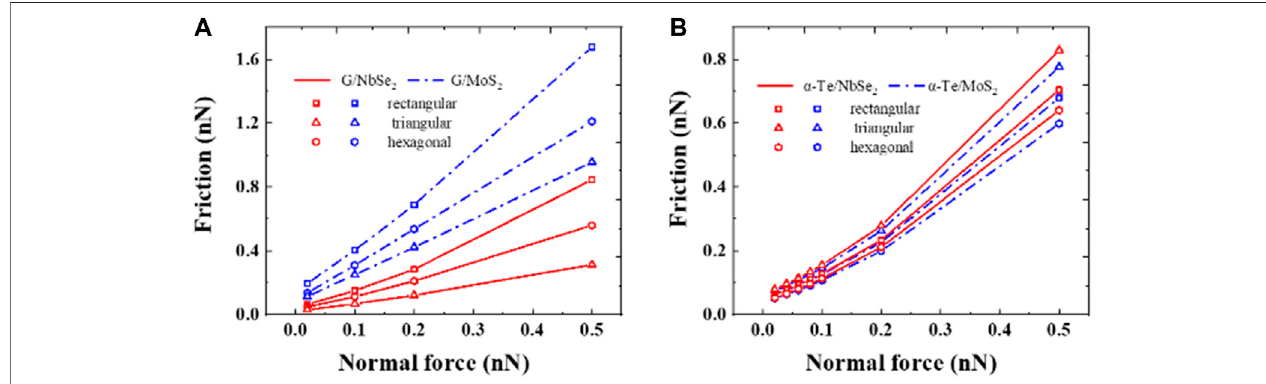
FIGURE 15 | Effect of normal forces on interlayer friction. The shape of the data points represents the shape of the slider in the simulation, which are rectangular, triangular, and hexagonal. (A) graphene/MoS 2 and graphene/NbSe 2 heterostructures; (B) α -Te/MoS 2 and α -Te/NbSe 2 heterostructures.